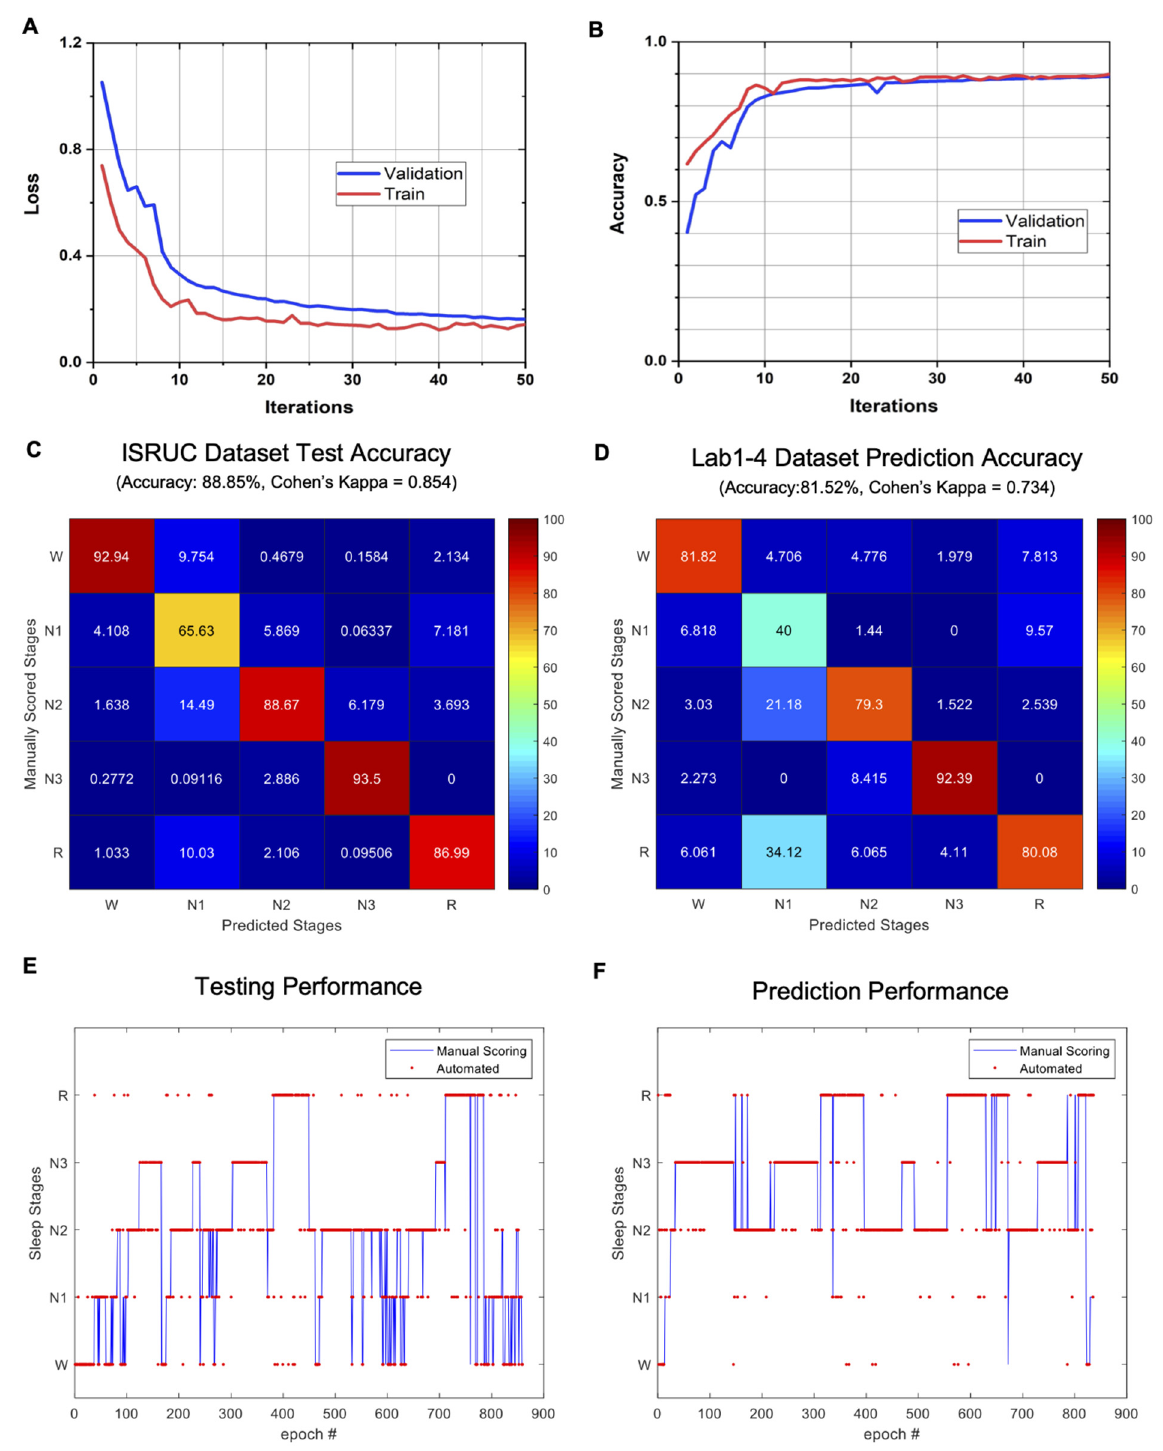
Figure 3. CNN classification results. ( A ) Loss curves of the training on the ISRUC dataset (red: loss on the training; blue: loss on the testing). ( B ) Accuracy curves of the training on the ISRUC dataset (red: accuracy on the training; blue: accuracy on the testing). ( C ) Confusion matrix with the public dataset (accuracy 88.85%, Cohen’s kappa = 0.854). ( D ) Confusion matrix with lab dataset (accuracy 81.52%, Cohen’s kappa = 0.734). ( E , F ) Hypnograms of prediction results from the ISRUC ( E ) and lab datasets ( F ).